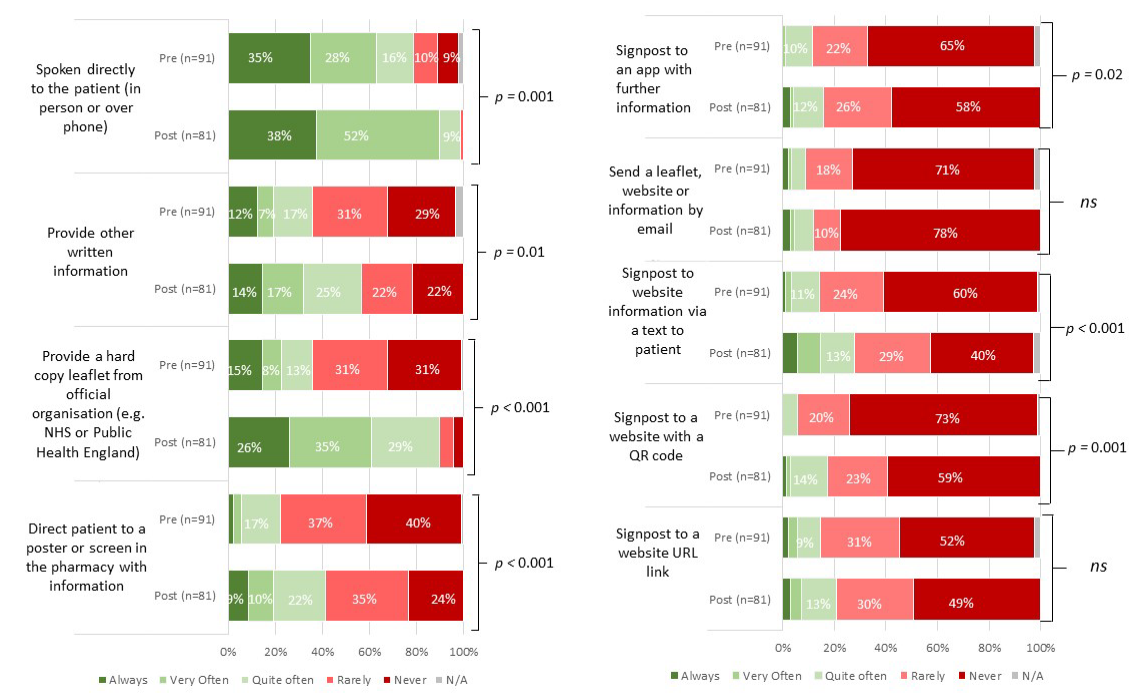
Figure 5. Community pharmacy staff method of advice to patients, pre- and post-intervention. Phar-